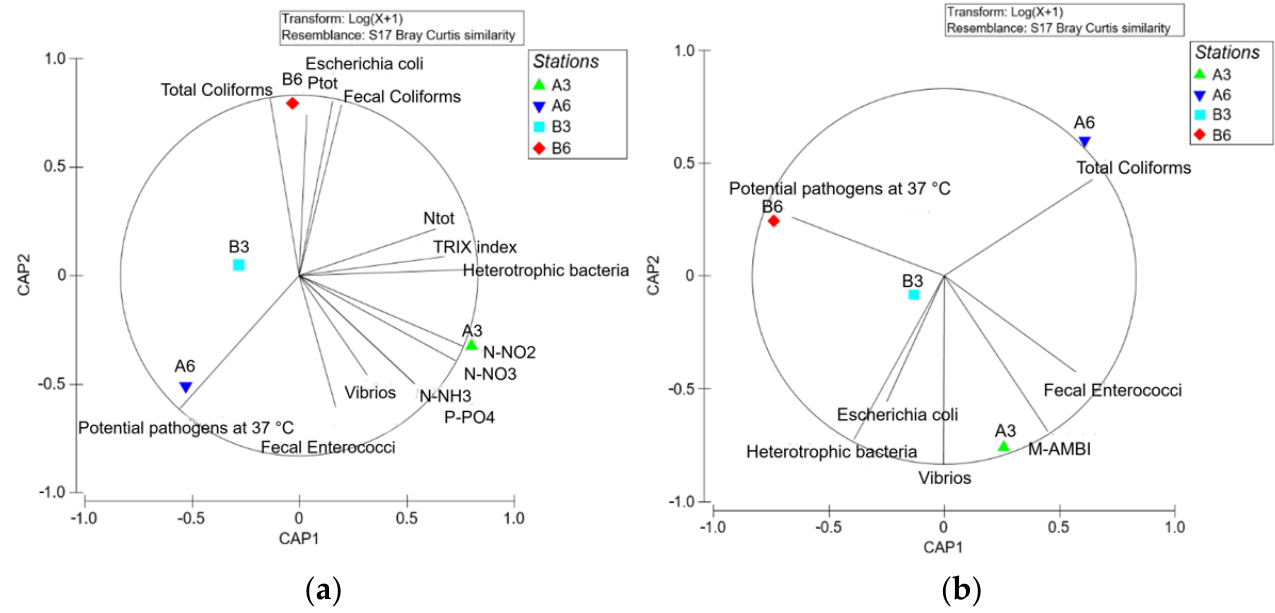
Figure 8. CAP analysis of the mean (February and July 2018) values of the measured parameters: ( a ) water sample; ( b ) sediment samples (modified from [28] with permission from IEEE, 2022, Copyright Clearance Center’s RightsLink ® ).